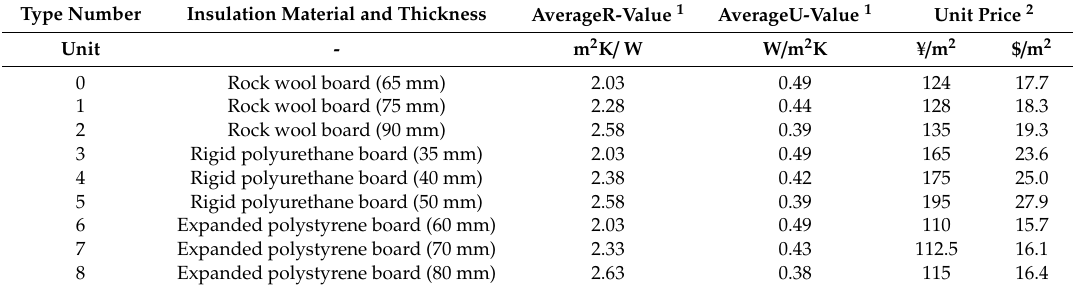
Table 2. Thermal and price properties of wall construction types with di ff erent insulations.